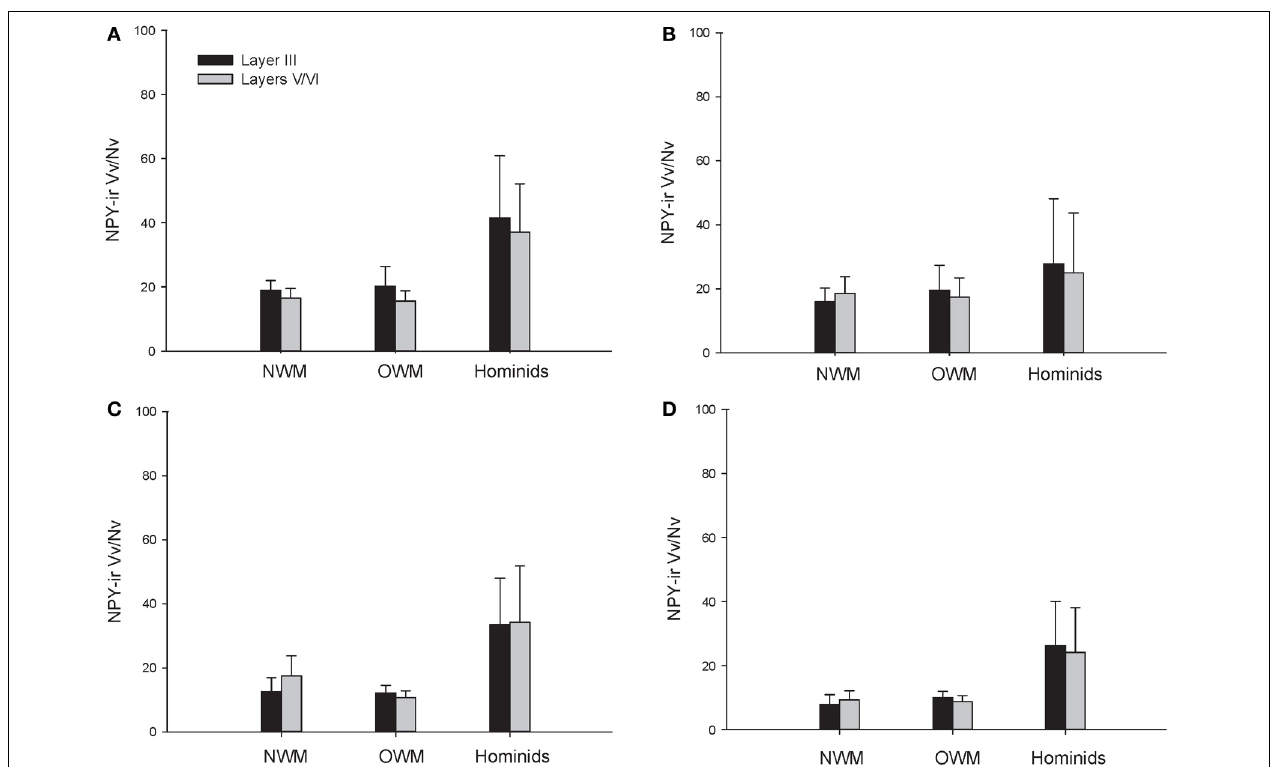
FIGURE 9 | NPY-irVv/Nv collapsed into phylogenetic groups for (A) area 10, (B) area 24, (C) area 44, and (D) area 22. OWM, Old World monkeys; NWM, New World monkeys. Means are shown by bars. Error bars indicate standard